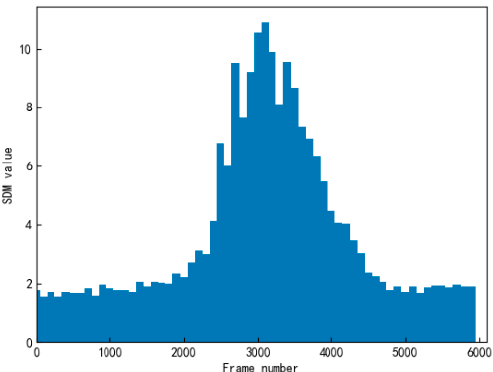
Figure 9. Distribution of the SDM value of the response patch. We can see an obvious unimodal distribution. Hence, selecting an appropriate threshold to judge occlusion and non-occlusion. distribution. Hence, selecting an appropriate threshold to judge occlusion and